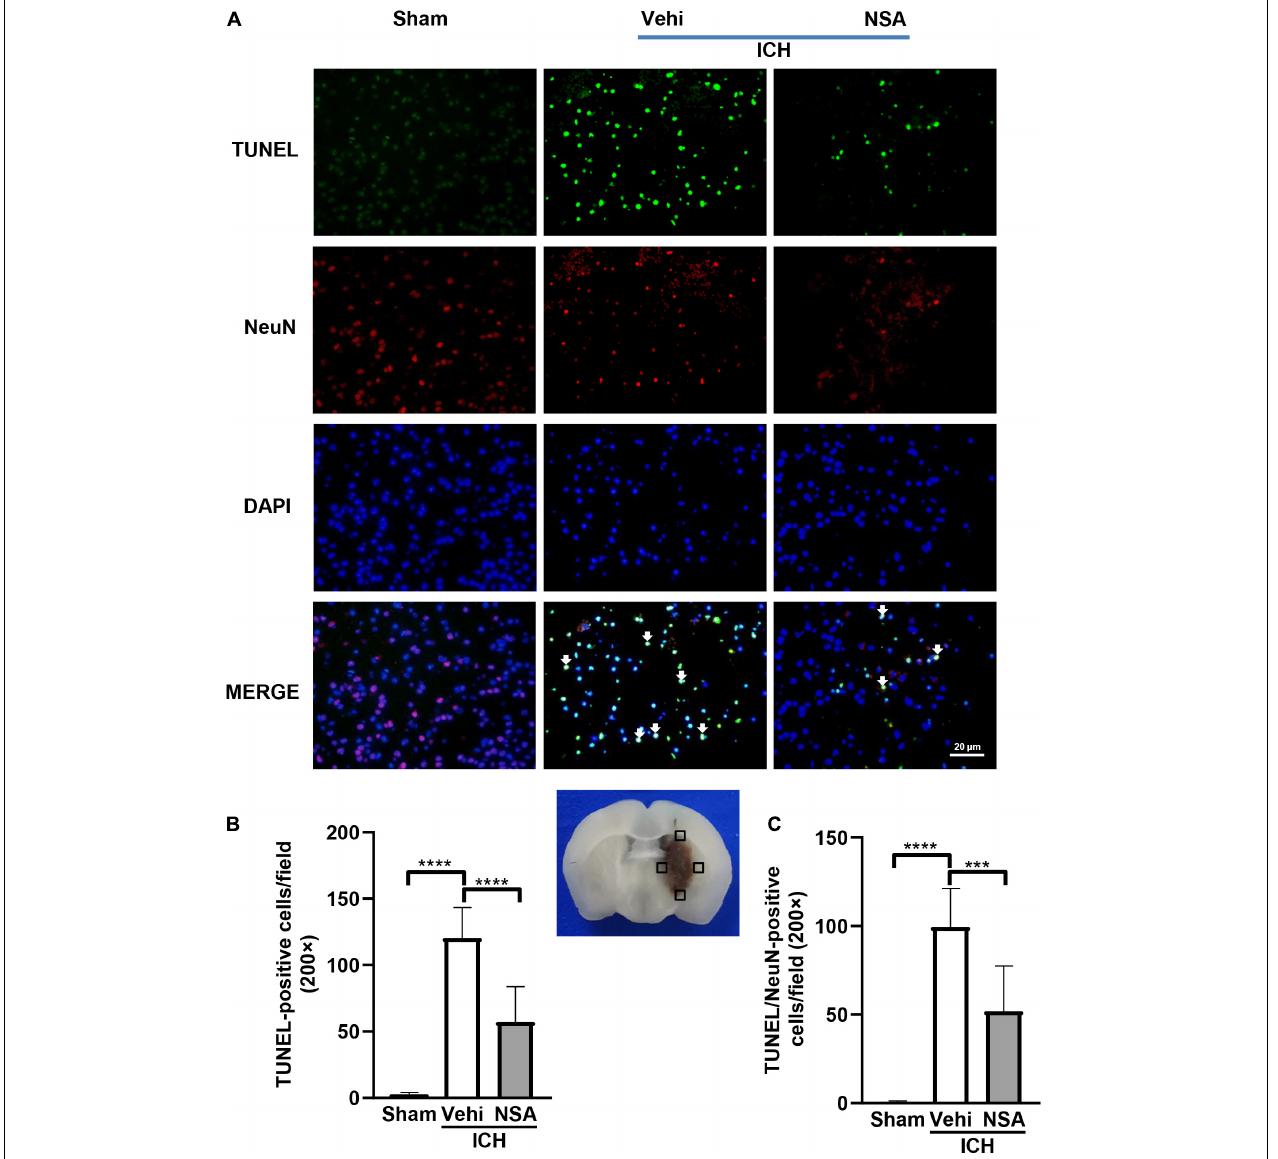
FIGURE 4 | The effect of necrosulfonamide (NSA) on death of neurons. (A) Representative photographs of TUNEL positive cells, NeuN positive cells, and TUNEL and NeuN double positive cells (white arrows) in the perihematomal area. (B) Quantitative analysis of TUNEL positive cells in the perihematomal area at 3 days after intracerebral hemorrhage (ICH). (C) Quantitative analysis of TUNEL positive neurons in the perihematomal area at 3 days after ICH. Data are shown as mean ± SD ( n = 6, per group); scale bar = 20 µ m; *** p < 0.001, **** p <